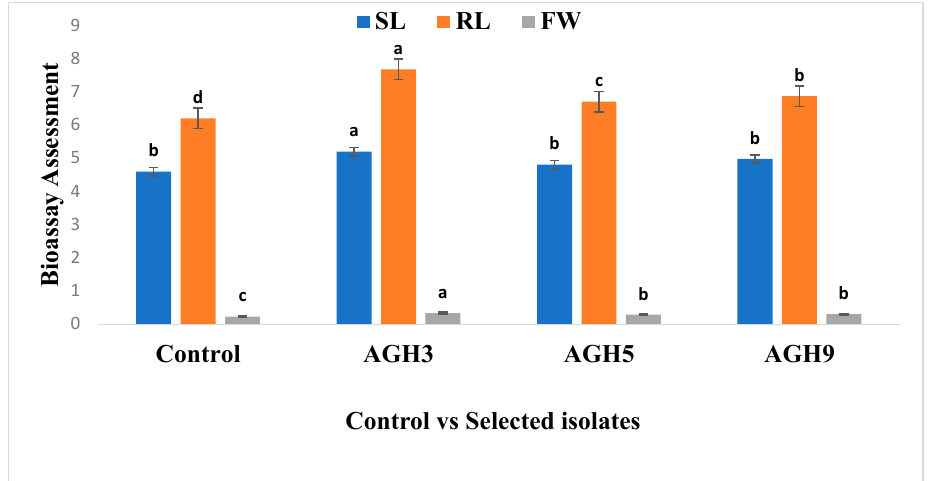
Figure 1. Bioassay assessment for growth promotion activity of selected isolates (AGH3, AGH5, and AGH9). Shoot length (SL); root length (RL); and fresh weight (FW). Different letters in the column show that values are significantly different ( p < 0.05) from each other as evaluated from the DMRT test.